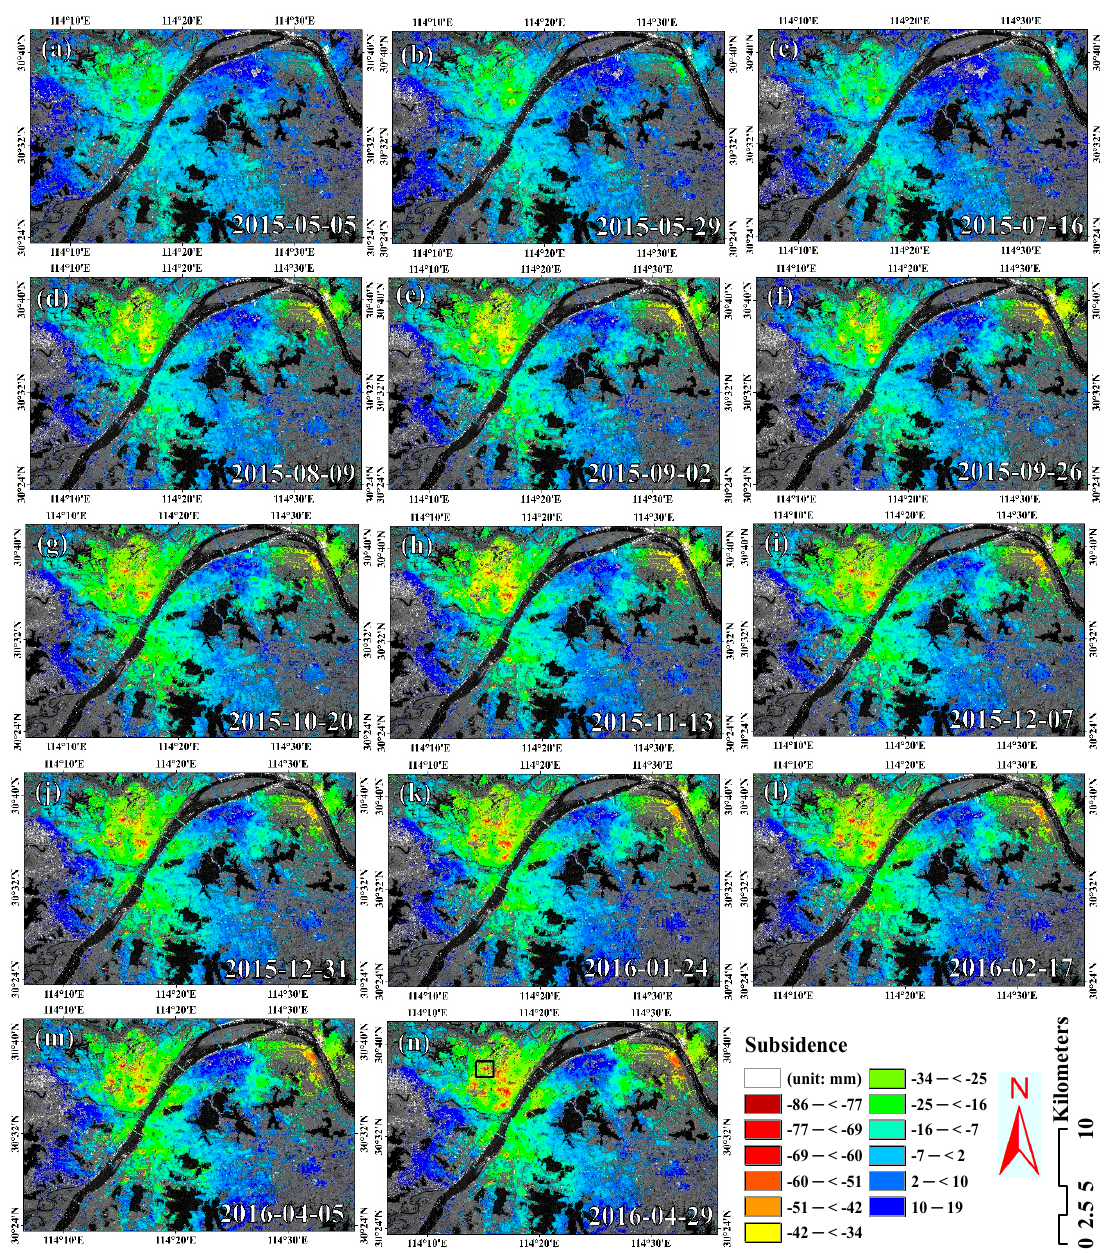
Figure 4. Cumulative subsidence (in the vertical direction) time series from 2015 to 2016. The image acquired on 11 April 2015 was not shown because it was selected as a reference image. The background is Sentinel-1A TOPS mean intensity image of Wuhan. ( a – n ) Cumulative subsidence in 14 stages